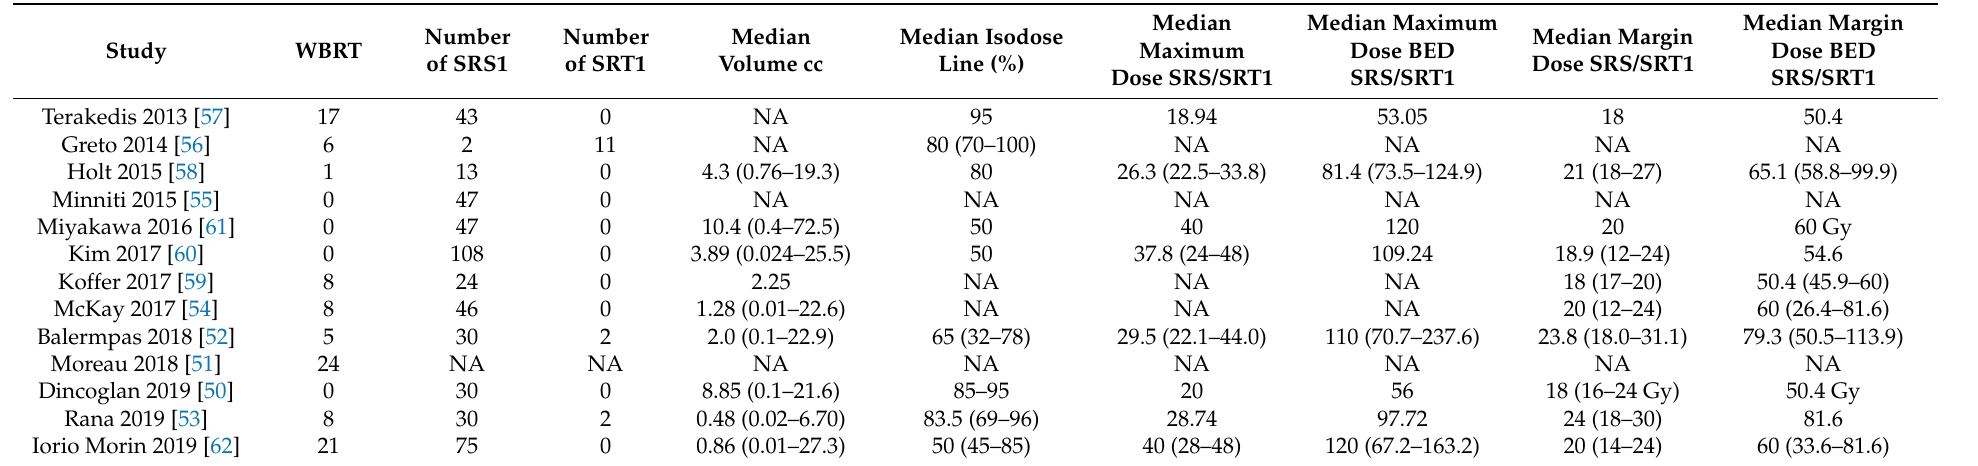
Table 3. SRS1/SRT1 treatment